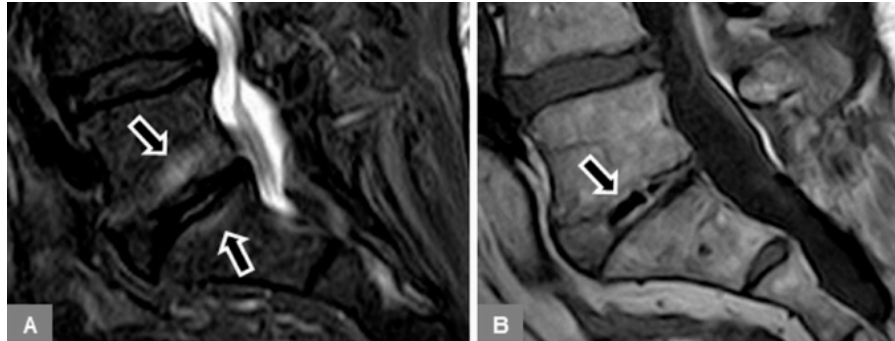
Figure 6. Intervertebral disc vacuum phenomenon in Modic type 1. A 73-year-old female patient with vertebral bone marrow edema on a sagittal STIR image at L5/S1 ( A , arrows), with the vacuum phenomenon seen as a low signal intensity within the degenerated, height-reduced disc on a sagittal T1-w image ( B , arrow).